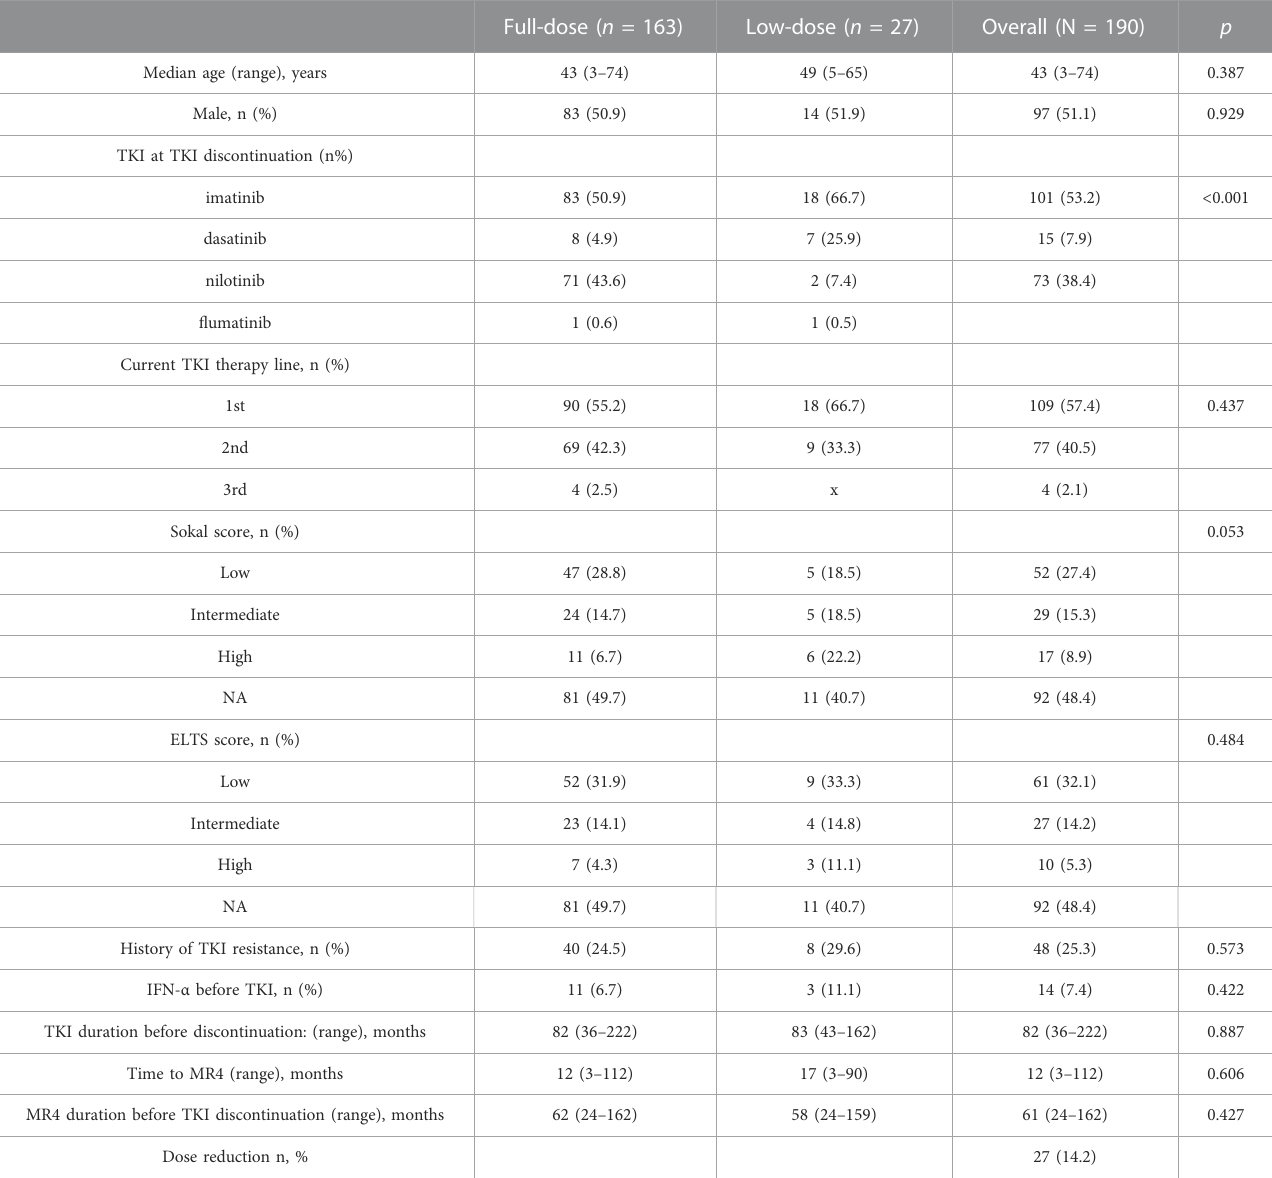
TABLE 1 Patient characteristics.